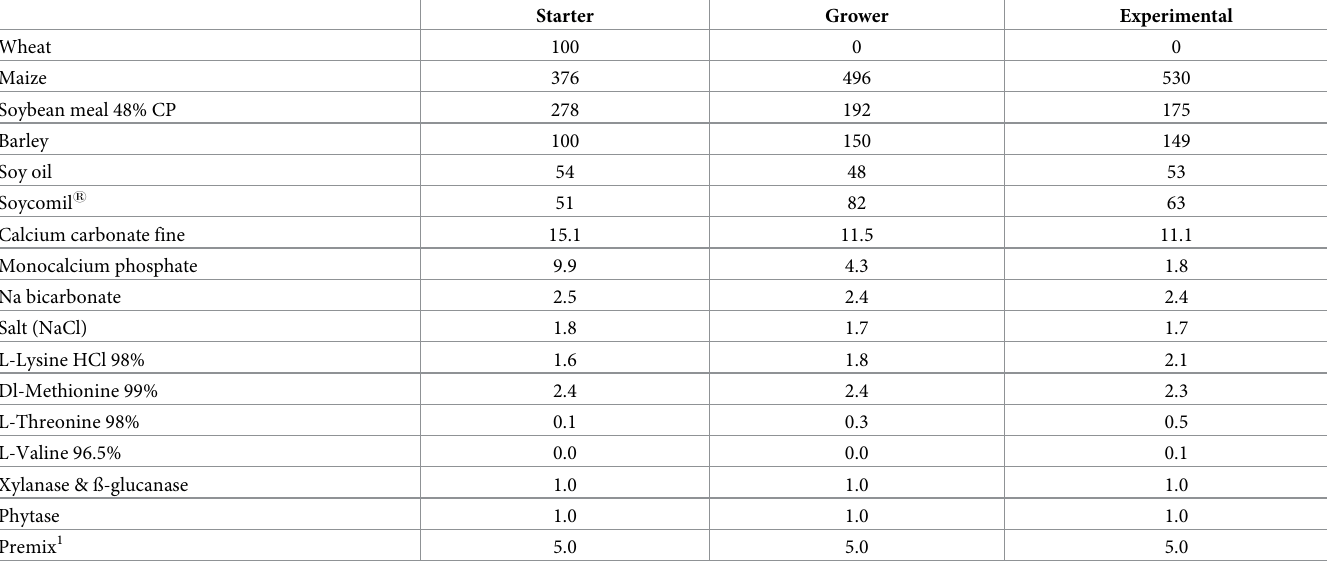
Table 1. Feedstuff composition (g/kg) of the adaptation diets (starter and grower phase) and experimental diet.